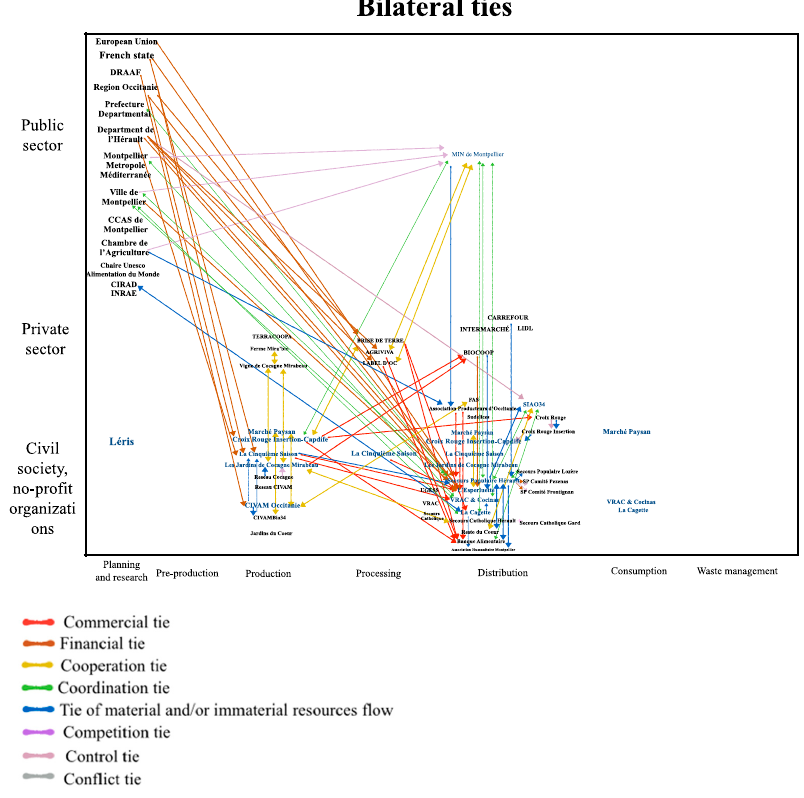
Figure 6. The bilateral ties.